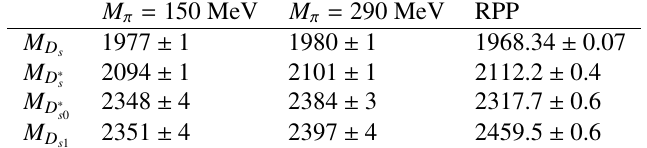
Table 1. Masses of the ground state 0 + and 0 − charm-strange mesons in the lattice calculation using two di ff erent pion masses in Ref. [44]. The experimental values [13] are given in the last column. All values are in units of